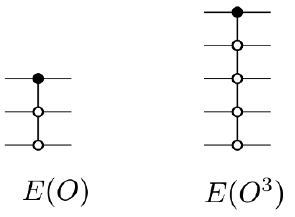
Figure 11 . De(cid:12)nition of the MPS tensor O (cid:5) T .